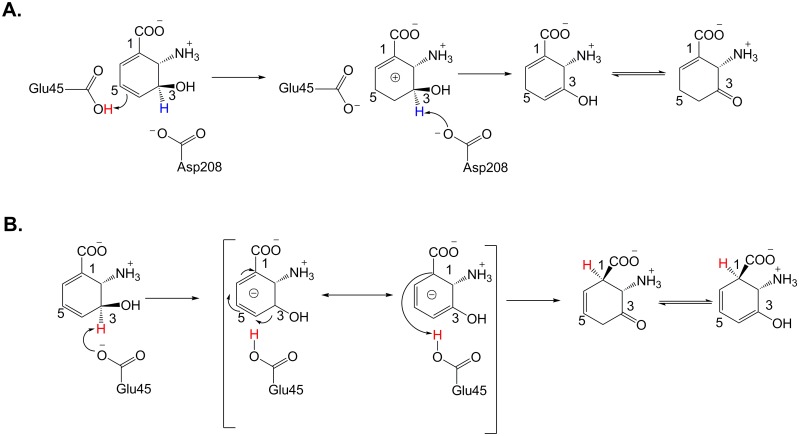
Proposed Mechanisms for Catalysis by PhzF [27, 31].